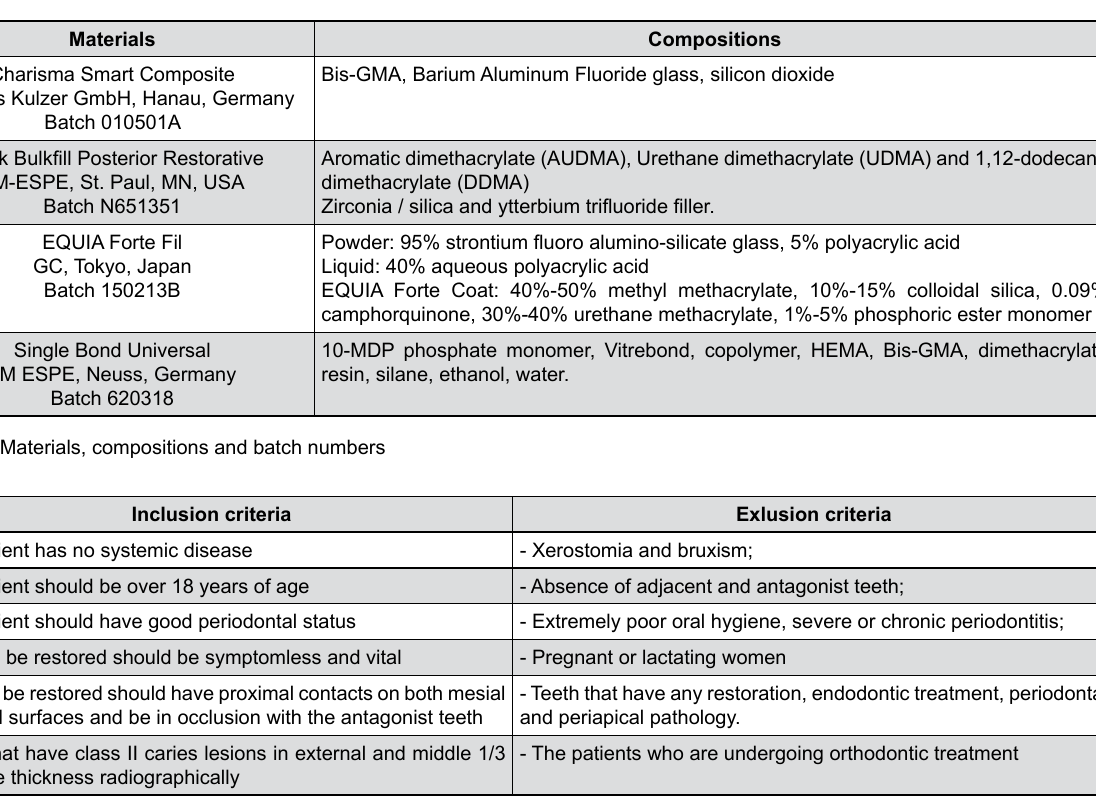
Figure 2- Inclusion and exlusion